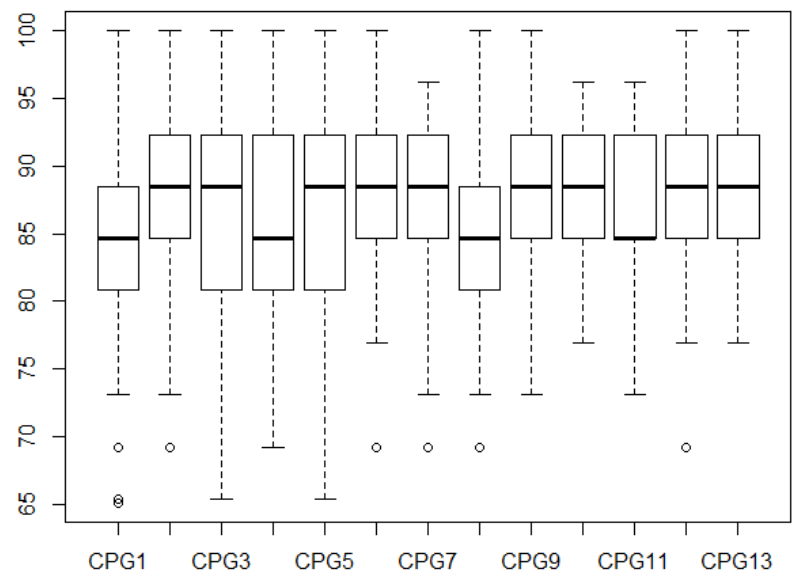
Figure 6. Classification accuracy (%) of each CpG individually.